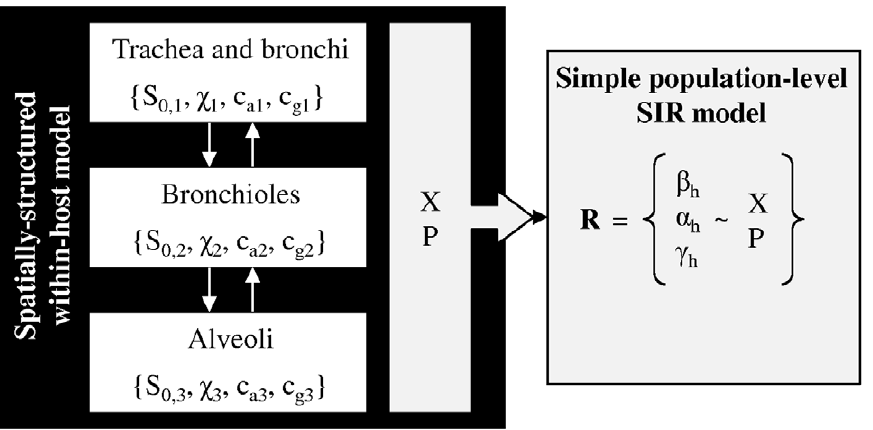
Figure 1. Conceptual overview of the framework. Within-host models of infection dynamics in a spatially-structured respiratory tract composed of three linearly-connected compartments are used to estimate overall virus excretion (X) and pathogenicity (P). The parameters that differ per respiratory compartment (i) are the initial number of susceptible cells (S 0,i ), the viral clearance rate ( x i ), and the distribution coefficients of immunoglobulins of type A (IgA) and IgG (c ai and c gi , respectively). The measures of virus excretion (X) and pathogenicity (P) in turn are used to estimate population-level transmission rate ( b h ), mortality rate ( a h ), and recovery rate ( c h ), which define the virus reproductive number (R). See Methods for more details.